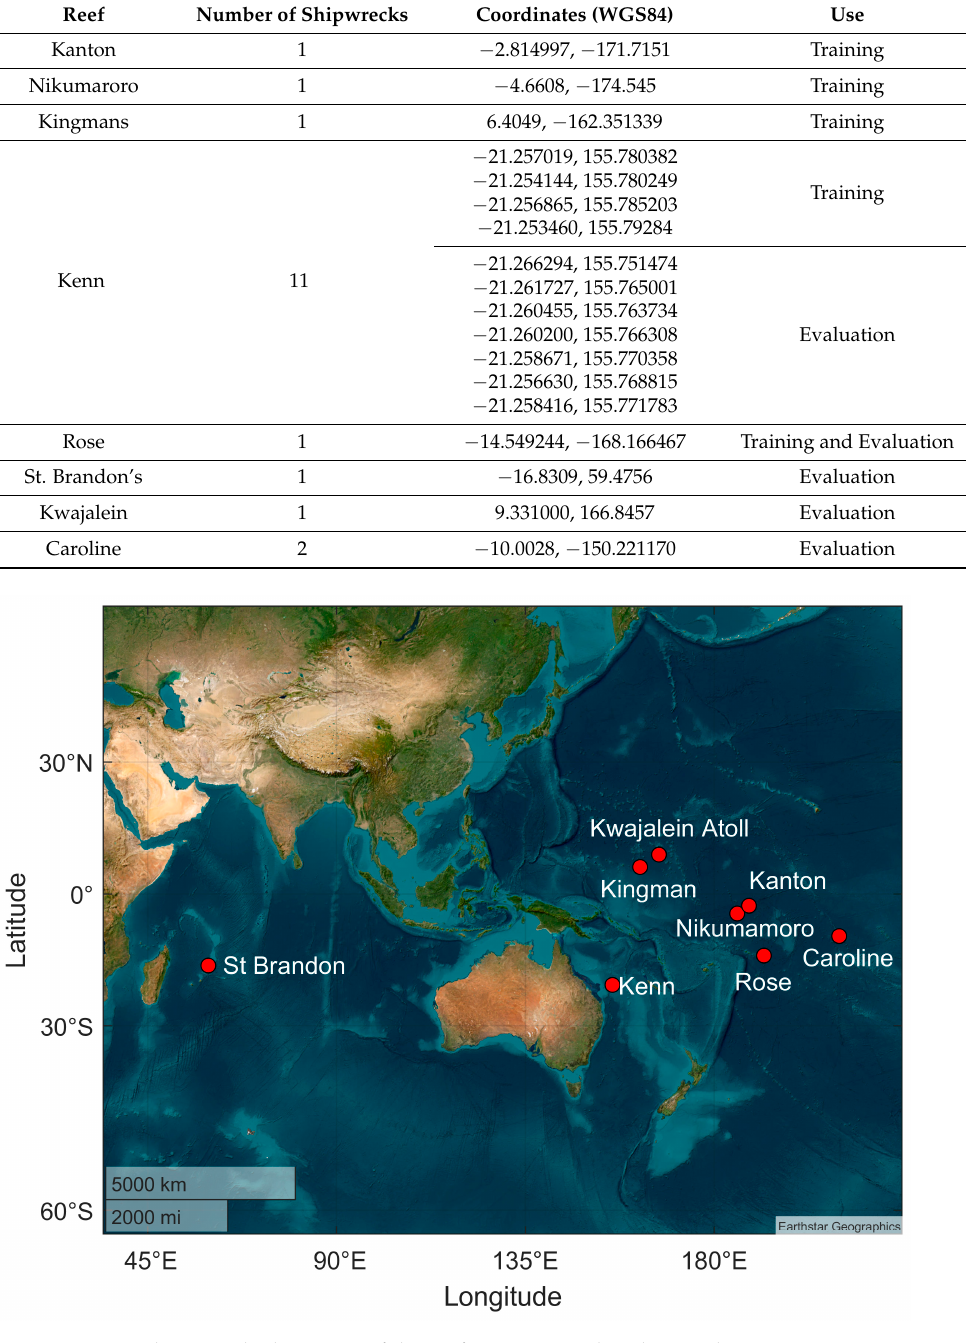
not all black reefs are visible in satellite imagery, nor is free imagery available for all reefs.